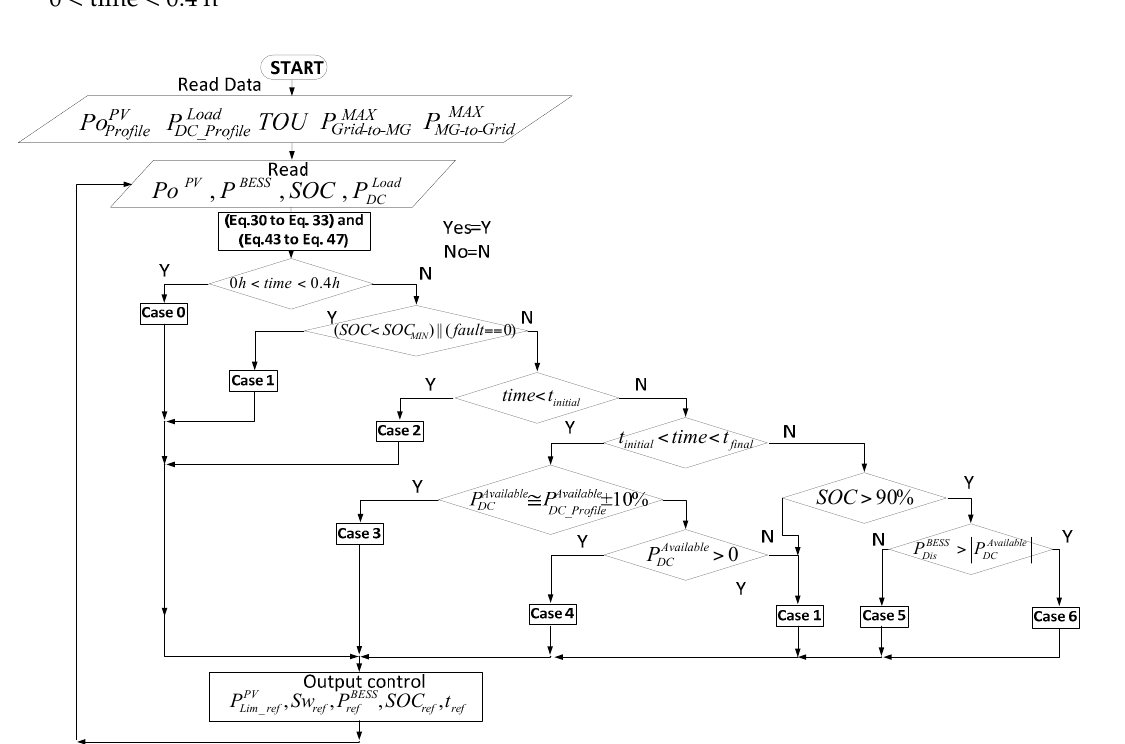
Figure 10. Power management algorithm implemented.